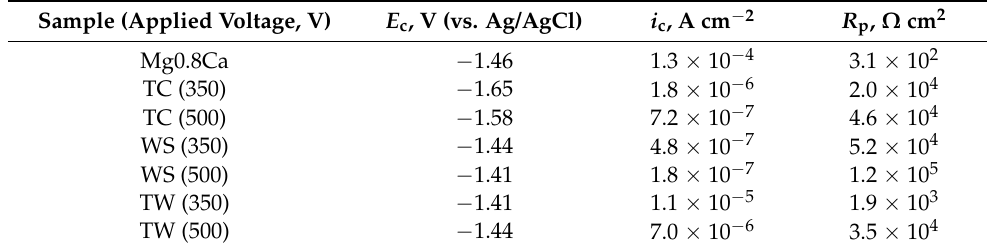
Figure 13. Potentiodynamic polarization (PDP) curves obtained in 0.9% NaCl for the bare Mg0.8Ca alloy and the coatings formed at 350 V ( a ) and at 500 V ( b ). Table 4. Electrochemical parameters.